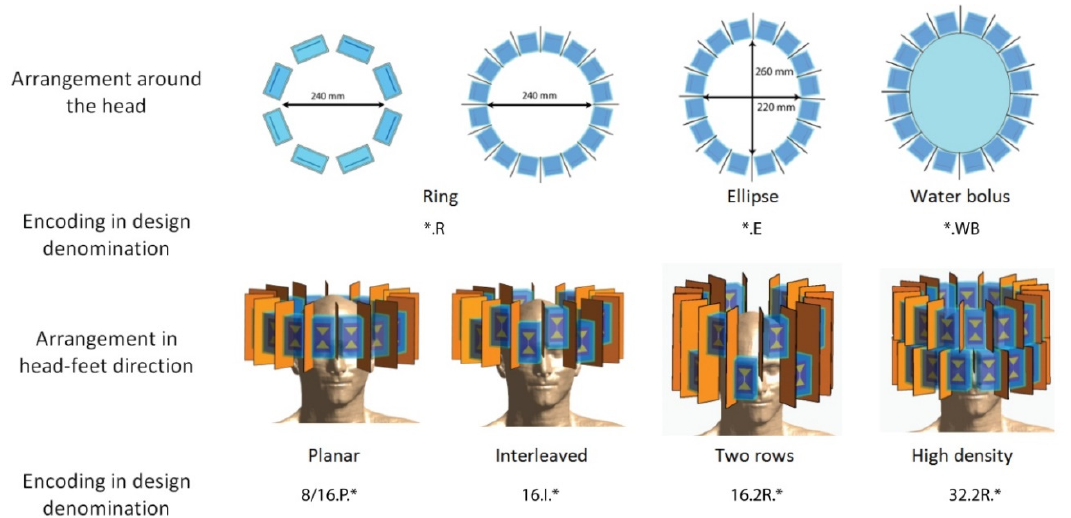
Figure 2. Schematic overview summarizing the RF applicator design elements (arrangement around the head, number of transmit elements and arrangement in the cranial–caudal direction, presence of a water bolus) and their encoding in the design denomination.